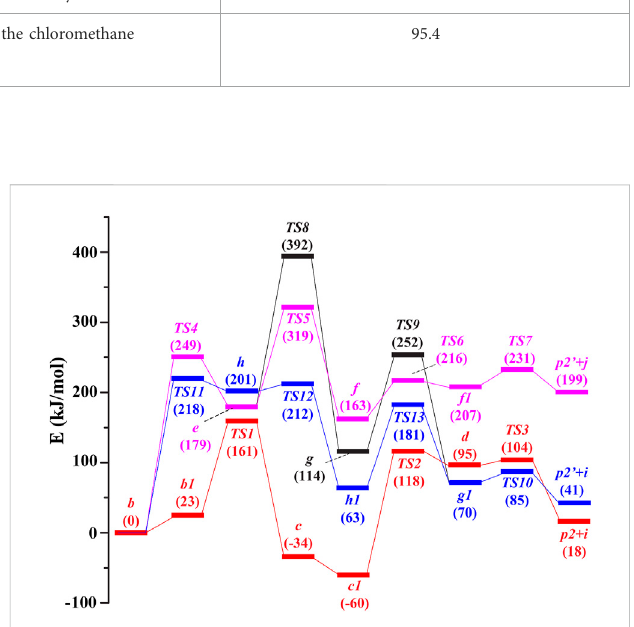
FIGURE 2 Potential energy diagram for the generation of m/z 246 in the dissociation of [melphalan + H – NH 3 ] + at the B3LYP/6-31+G (d, p ) level. Red line: route 1, rose red line: route 2-A, black line: route 2-B, blue line: route 3. i: CH 2 CO, j: CH ≡